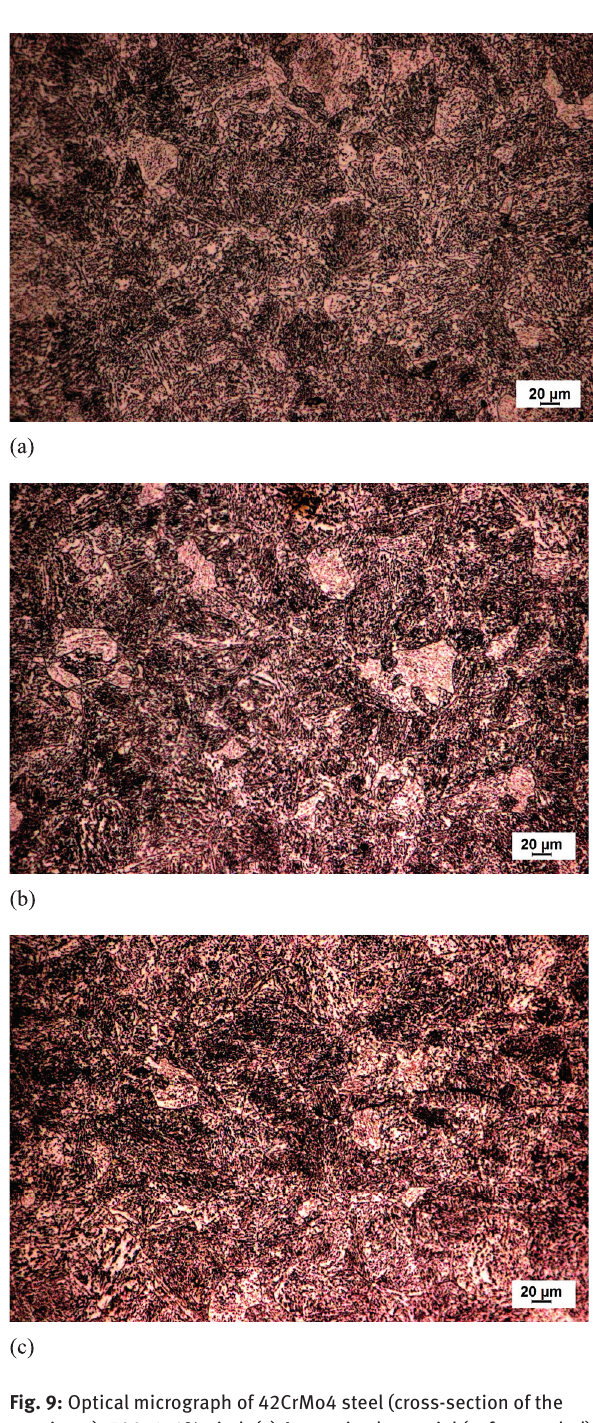
Fig. 9: Optical micrograph of 42CrMo4 steel (cross-section of the specimen); 500: 1; 4% nital. (a) As-received material (soft annealed), considered in this work, cross-section of the specimen. (b) After the creep process performed at 500 °C (773 K)/113.6 MPa/1200 min, cross-section of the specimen. (c) After the creep process performed at 500 °C (773 K)/113.6 MPa/1200 min, lengthwise section of the specimen.